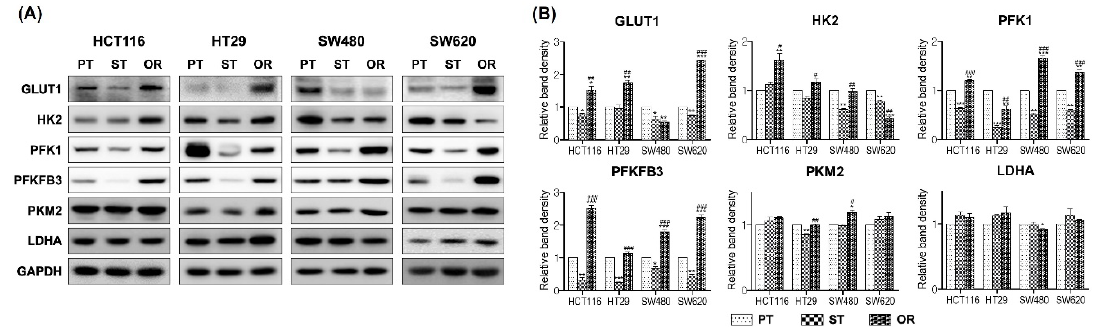
Figure 6. Effect of oxaliplatin resistance on enzymes involved in the glycolysis in the parental (PT), 2.5 µM oxaliplatin single treated PT for 24 h (ST) and oxaliplatin-resistant (OR) colorectal cancer (CRC) cells of HCT116, HT29, SW480 and SW620. ( A ) Protein expression was determined by immunoblot analysis. ( B ) Graphical analysis of band intensities normalized for protein loading with GAPDH. Columns and error bars represent means ± standards deviation of immunoblot band intensities of 3 separate protein preparations. The * statistics showed the comparison with PT and the # statistics showed the comparison between ST and OR. * or # , p < 0.05; ** or ## , p < 0.01; *** or ### , p < 0.001. GLUT1, glucose transporter 1; HK2, hexokinase 2; PFK1, phosphofructokinase 1; PKM2, pyruvate kinase M2; LDHA, lactate dehydrogenase A; PFKFB3, 6-phosphofructo-2-kinase/fructose-2,6-biphosphatase 3; GAPDH, glyceraldehyde 3-phosphate dehydrogenase.